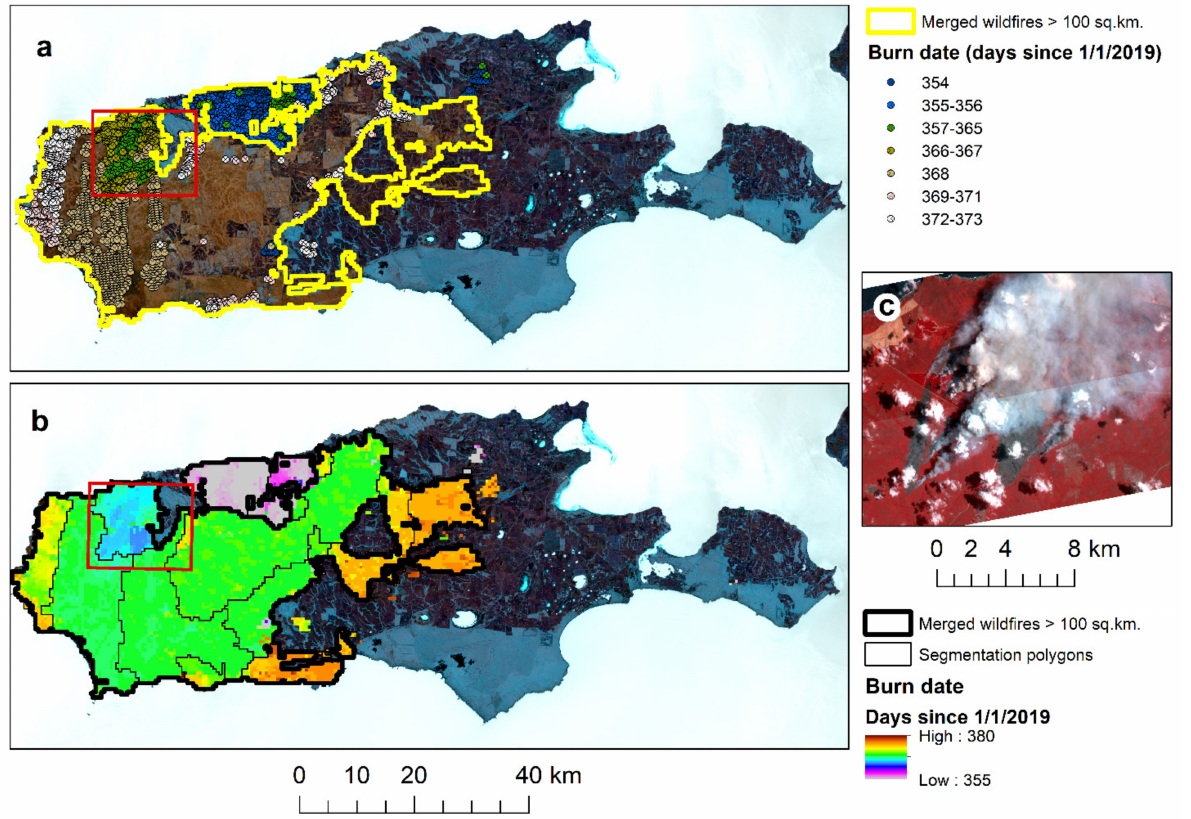
Figure 2. The steps in creating the wildfire polygons, showing Karta Pintingga/Kangaroo Island fires as an example. VIIRS active fires points ( a ) provide accurate date and time of active fires. However, many burnt areas (shown in brown in the false colour composite of the Landsat 8 image (10 February 2020)) ( a ) are often missing, probably due to cloud cover ( a ). The MODIS burnt area product, which includes the burnt date per pixel (at 500 m resolution), provides better spatial coverage of burnt areas ( b ). The segmentation polygons were visually assessed and joined into individual wildfires based on the burn date and spatial continuity of the wildfires ( b ). The false colour composite of the Planet Labs imagery (31 December 2019) shows the Kangaroo Island fire a few hours after it had started from lightning strikes ( c ). The burn date and the day of the year are counted from 1 January 2019 and, thus, day of year greater than 365 refers to fires that burnt at the beginning of